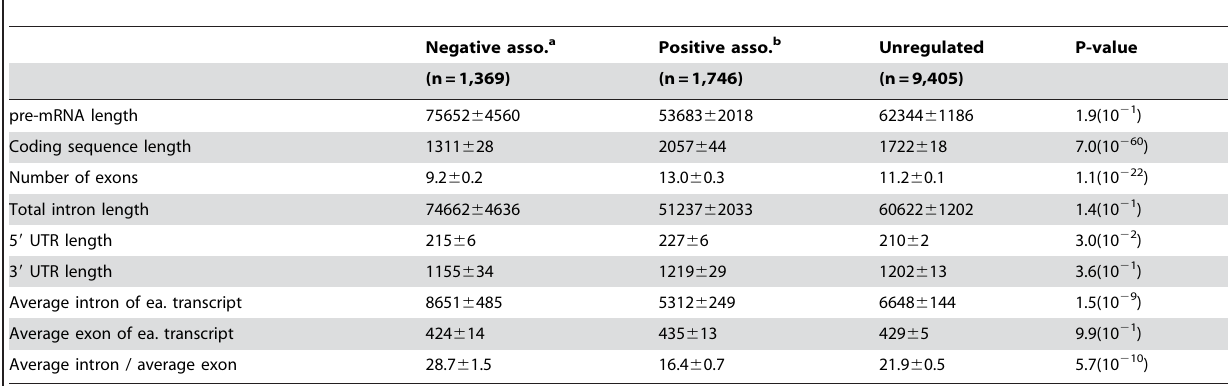
Table 9. Genomic architecture comparisons for age associated genes in human brain